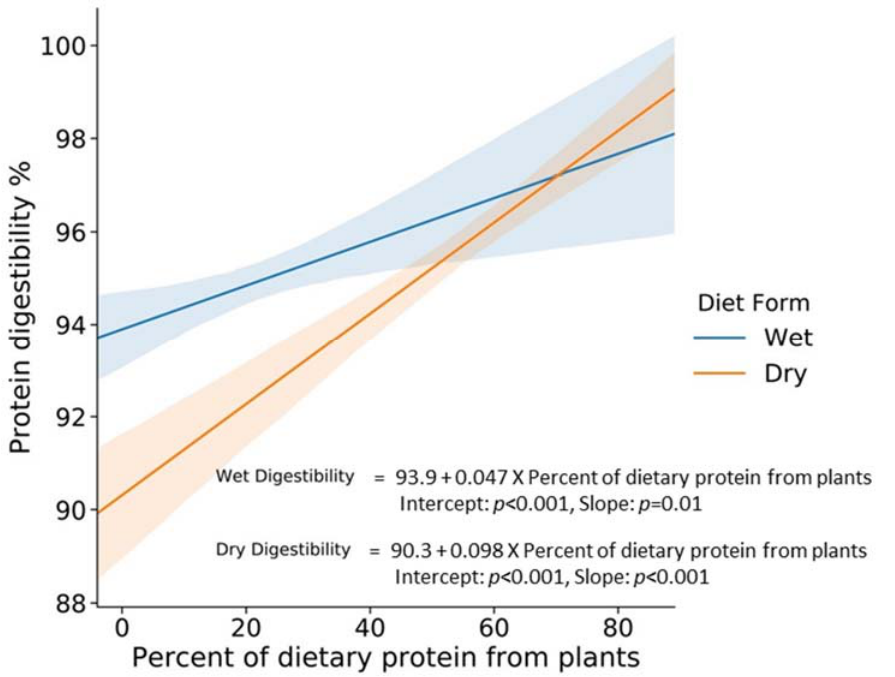
Figure 1. The e ff ect of dietary plant protein on protein digestibility in Figure 1. The effect of dietary plant protein on protein digestibility in cats.